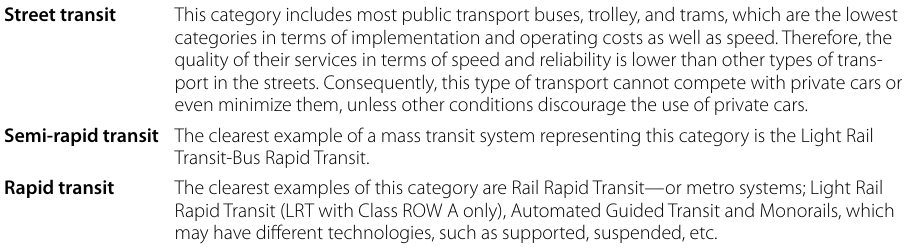
Prepared by the researcher and the information is obtained from reference no. [9]